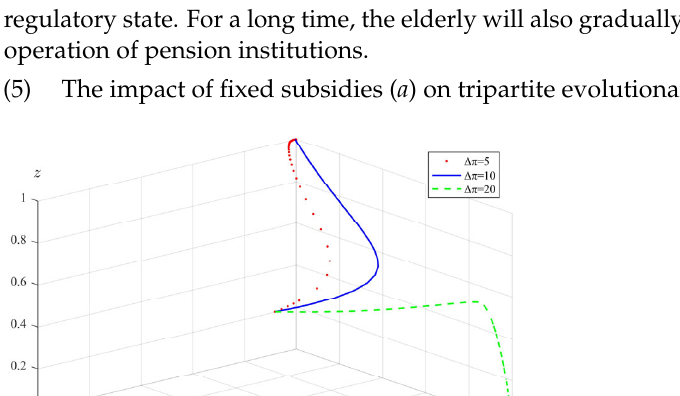
18 of 24 Figure 8. The impact of penalty coefficient ( η ) on the evolution of tripartite behavior. (4) The impact of additional benefits ( Δ𝜋 ) on tripartite evolutionary behavior In the same way, we changed the additional benefits obtained by private pension institutions from illegal operations, and took Δ𝜋 = 5, 10, 20; the evolution path is shown in Figure 9. It can be seen that with the increase in Δ𝜋 , the rate of government depart ‐ ments’ evolving to the state of full supervision is significantly accelerated. When Δ𝜋 = 20, private pension institutions have evolved from standardized operation to illegal opera ‐ tion, and the participation rate of the elderly has gradually evolved to zero. The above results show that under the condition that the supervision and rewards and punishments of government departments remain unchanged, when Δ𝜋 is small, private pension in ‐ stitutions will choose to operate in a standardized manner. As Δ𝜋 increases, the evolu ‐ tion rate of private pension institutions’ choosing regulated operation decreases signifi ‐